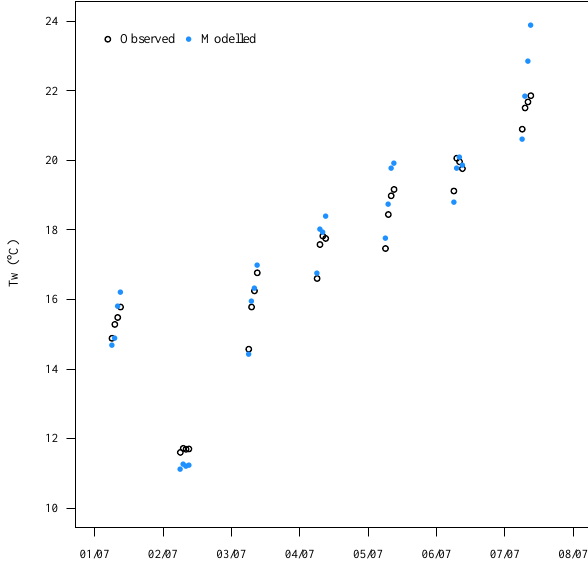
Figure 7. Observed and modelled water temperature at AWS FDS .